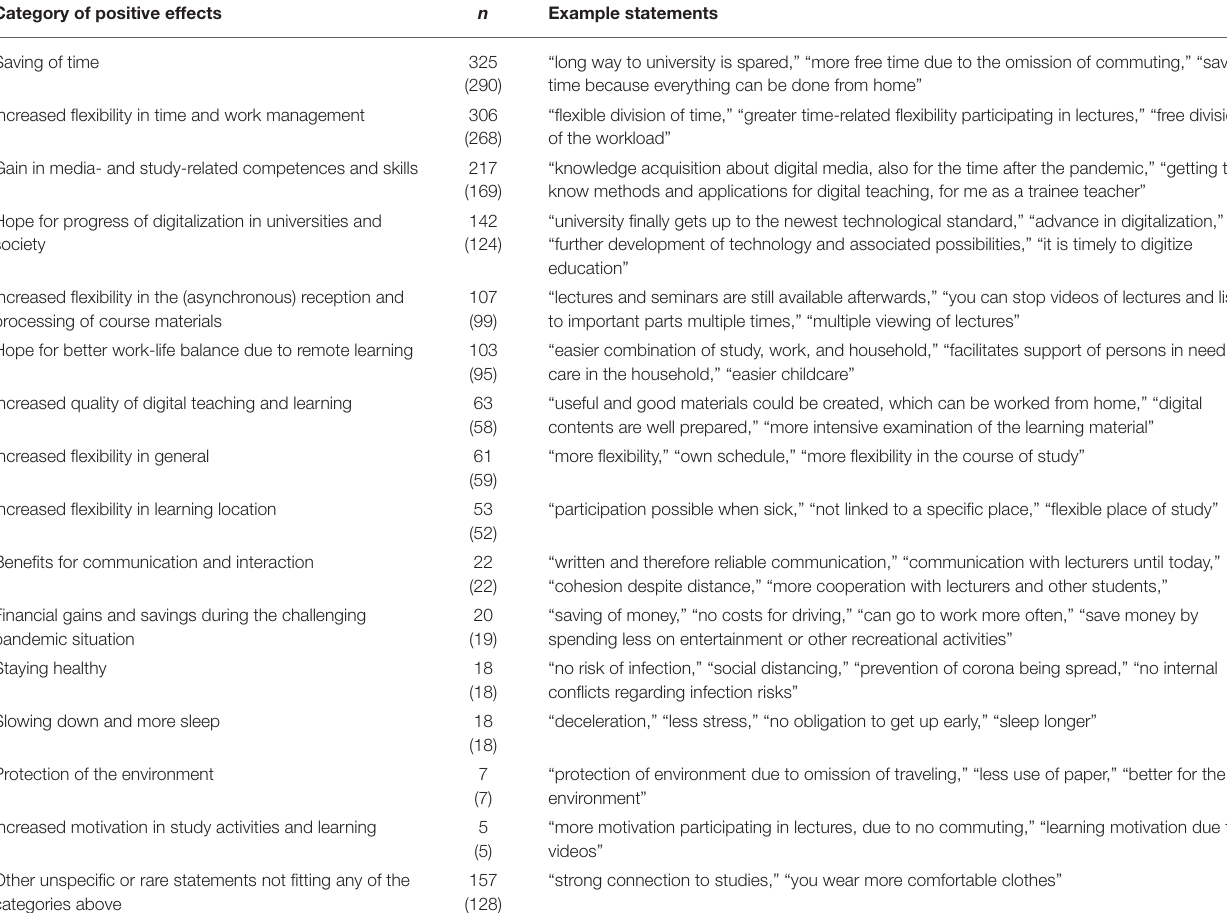
TABLE 2 | Category descriptions, number of statements in descending order, and example statements for positive